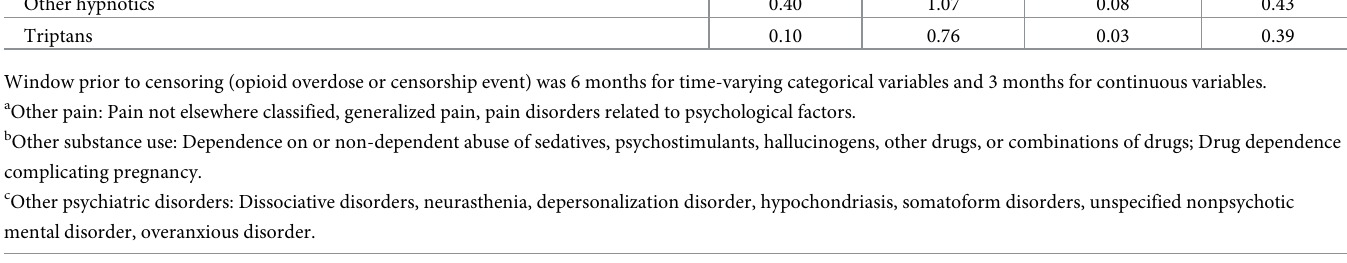
The elastic net model’s predicted probability of opioid overdose in the next month provided close, but slightly underestimated predictions of the observed risk ( Fig 2 ). However, the pre- dicted probabilities were higher than the true risk of overdose in patients in the highest percen- tile of risk ( > 99.99 th percentile). Random forest was slightly better calibrated compared to elastic net and traditional regression, particularly for patients with the highest predicted proba- bilities of opioid overdose ( Fig 2 ). The final elastic net model identified 40 predictors for opioid overdose in the next month based on the previous 3–6 months of medical history ( Table 3 ). All identified predictors were Table 2. Comparative performance of models and validation in subgroups in the test set. Model Comparison of Models Traditional logistic regression 1: Baseline only